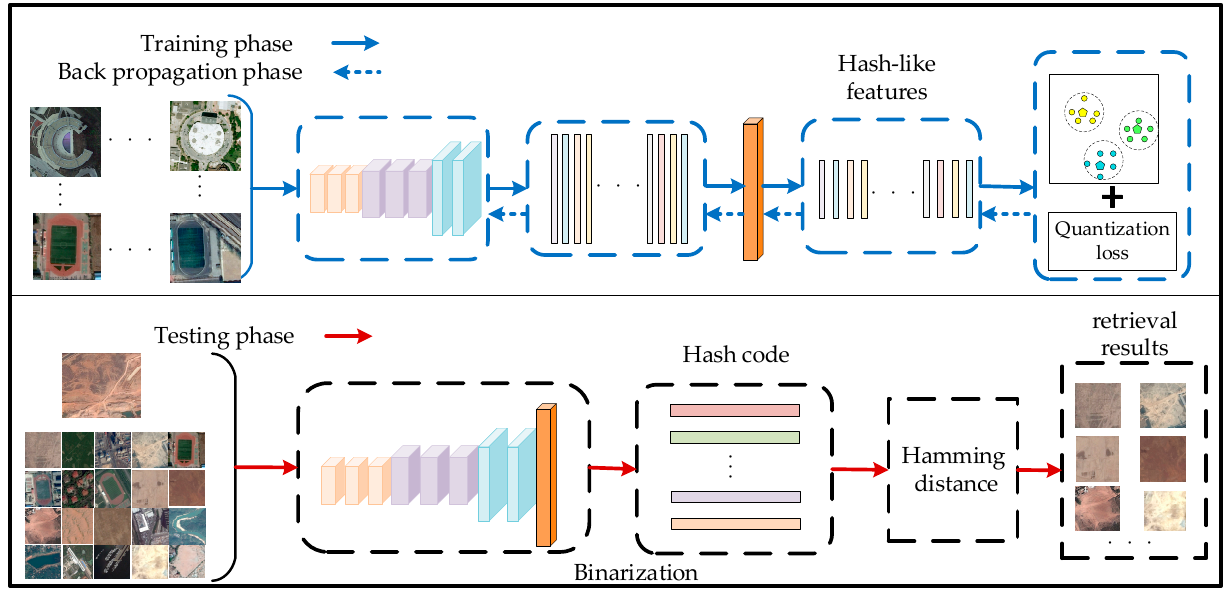
Figure 3. Image retrieval framework based on deep hashing using Proxy Loss.